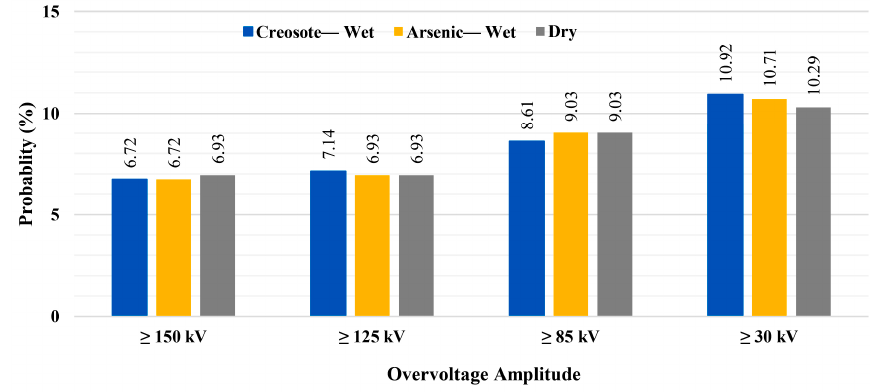
Figure 12. Comparison among the probabilities of transformer overvoltage stress, Case 1 (only transformer poles grounded).